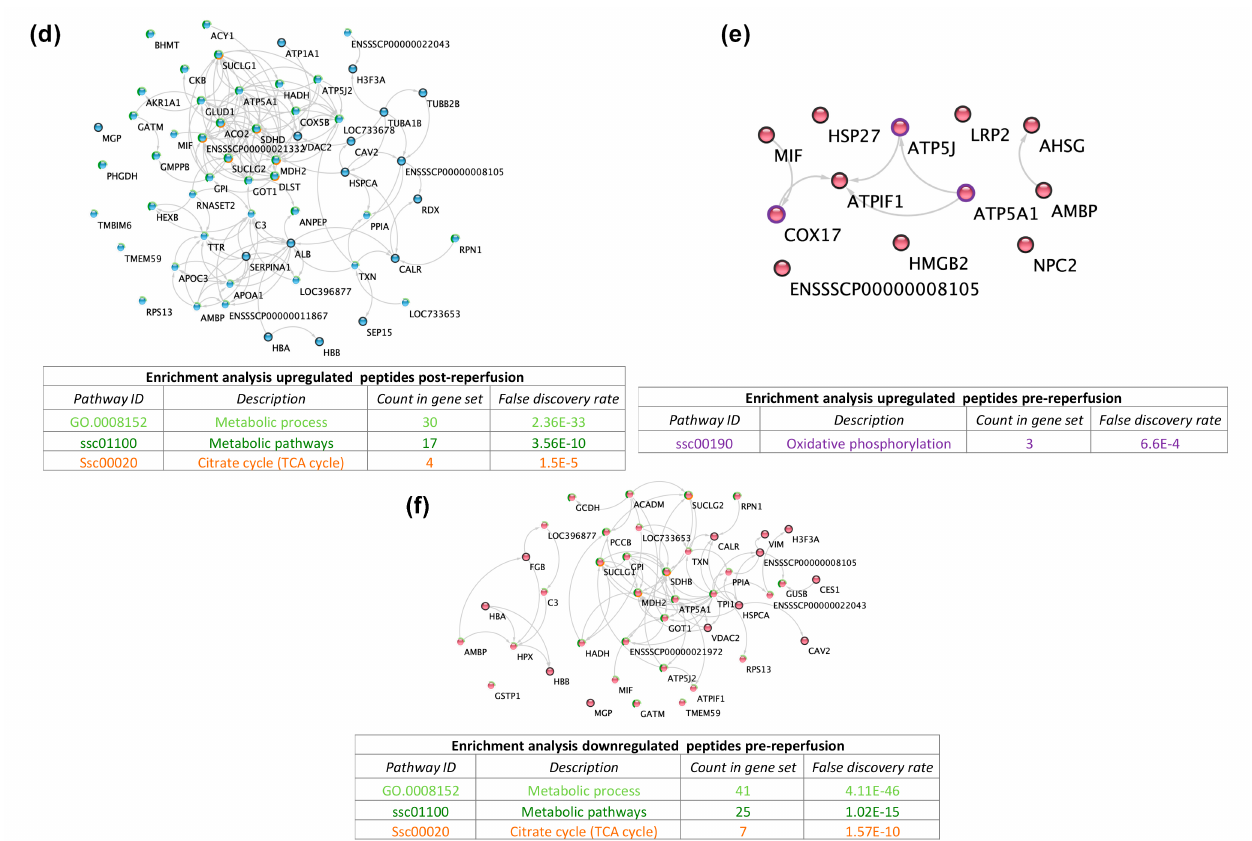
Figure 3. Renal tissue degradomics during ex vivo reperfusion modulated by doxycycline. ( a ) Heat map and hierarchical clustering of degradation products across all tissue samples. ( b ) Represents the log2 fold change of degradation products between DOXY and the control group pre-reperfusion (T-10). ( c ) Represents the log2 fold change of degradation products between DOXY and the control group post-reperfusion (T240). ( d ) Represents a KEGG pathways analysis of degradation products identified as significantly downregulated and ( e ) upregulated pre-reperfusion. ( f ) Represents a KEGG pathways analysis of degradation products identified as significantly upregulated post-reperfusion. DOXY; doxycycline